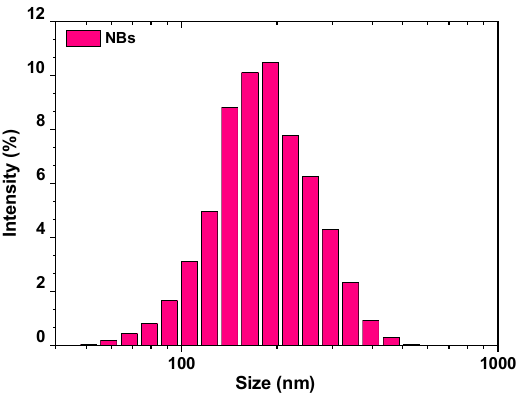
Figure 5. Pore size distribution of air bulk nanobubbles observed from dynamic light scattering measurements, at 25 °C. Reprinted with permission; copyright Elsevier [69] .